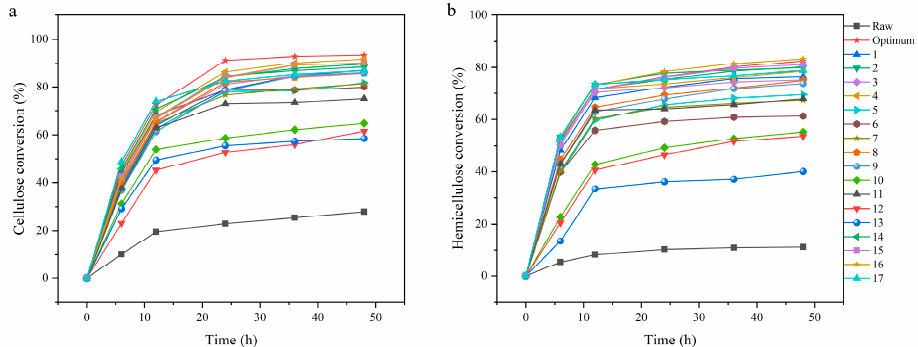
Figure 2. The curve of time–carbohydrate hydrolysis at pH 4.8 and 323.15 K. ( a ) Cellulose; ( b ) hemicellulose.